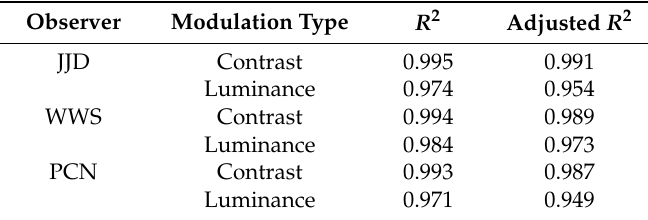
Table 1. Coefficients of determination for modulations of contrast and luminance disparity for observers JJD, WWS, and